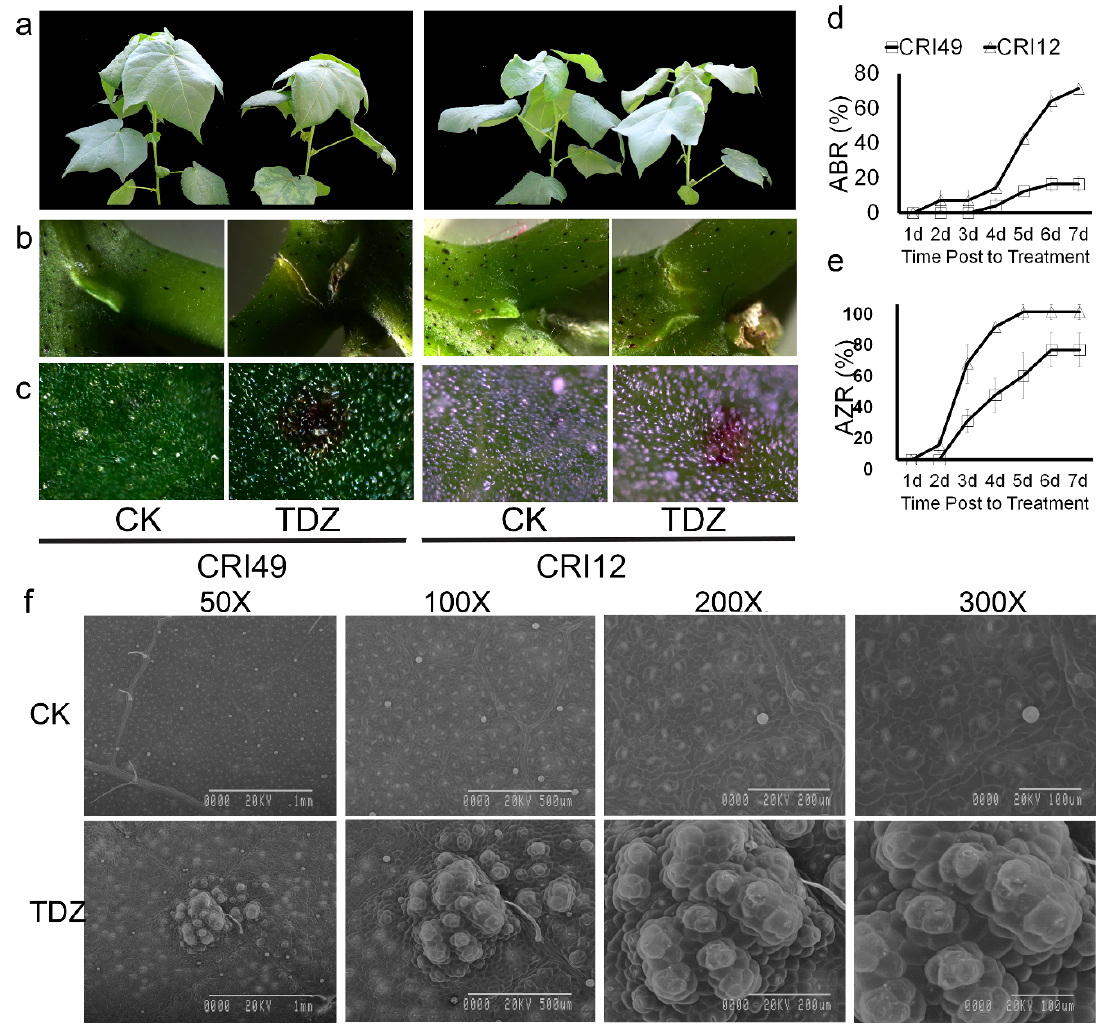
Figure 1. Phenotypic changes, abscission rate (ABR), and abscission zone formation rate (AZR) in CRI 49 and CRI 12, with or without Thidiazuron (TDZ) treatments. ( a ) whole plant (camera image); ( b , c ) abscission zone and leaf (T microscope image); ( d , e ) ABR and AZR represent abscission rate and abscission zone formation rate, respectively; ( f ) scanning electron microscopy of leaf epidermis cells of CRI 12. CK and TDZ represent control (water treatment) and 100 mg L − 1 TDZ treatment,